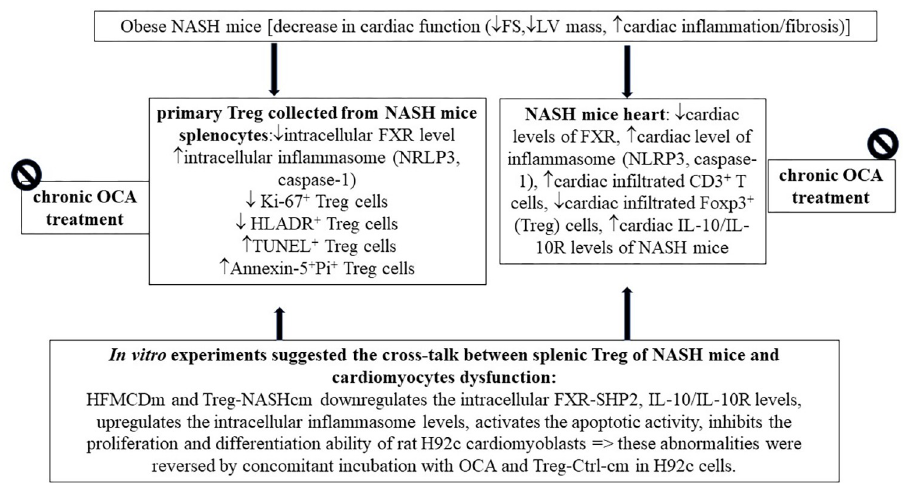
Fig 7. Graphical summary of the pathogenic mechanisms and effects of chronic OCA treatments on mice with NASH-related cardiac dysfunction. FM: Fat mass; FS: Fractional shortening; FXR: Farnesoid X receptor; SHP2: Small heterodimer partner 2; Treg: T regulatory cell; Treg-NASH: Treg cells of NASH mice; cm: Condition medium; HFMCD: High-fat and methionine and choline deficiency.